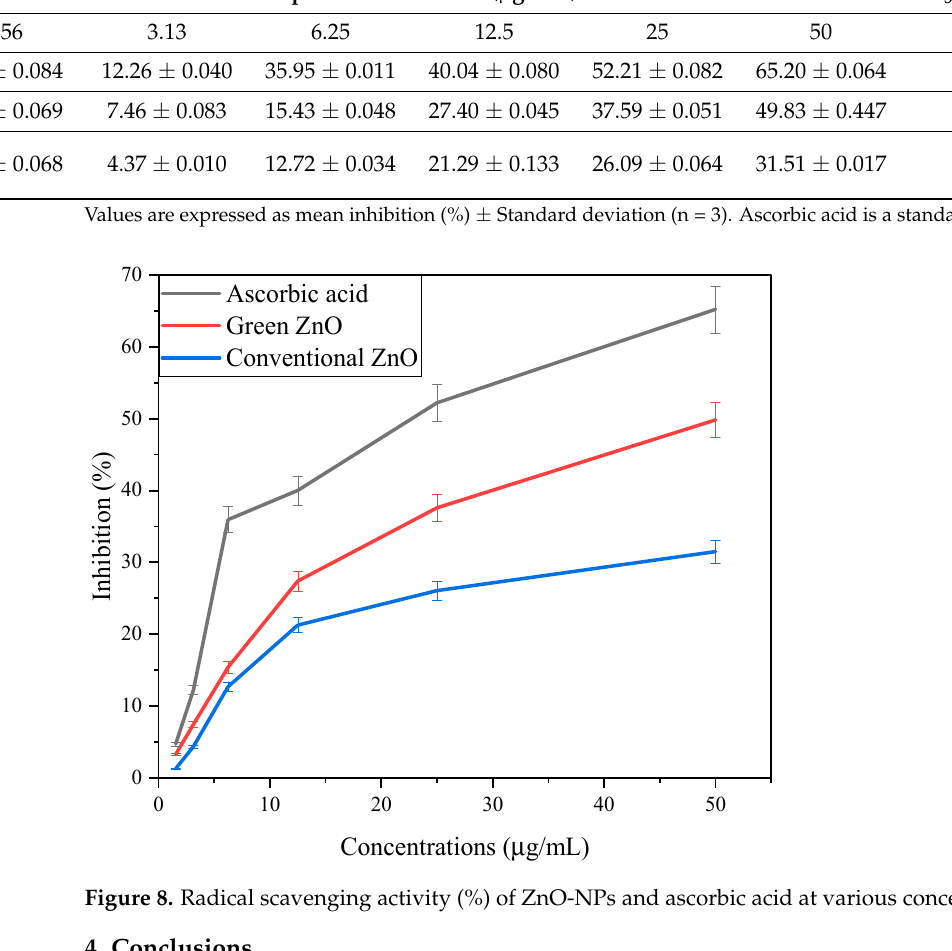
Table 3. Antioxidant activity (%) of green and conventional ZnO-NPs.